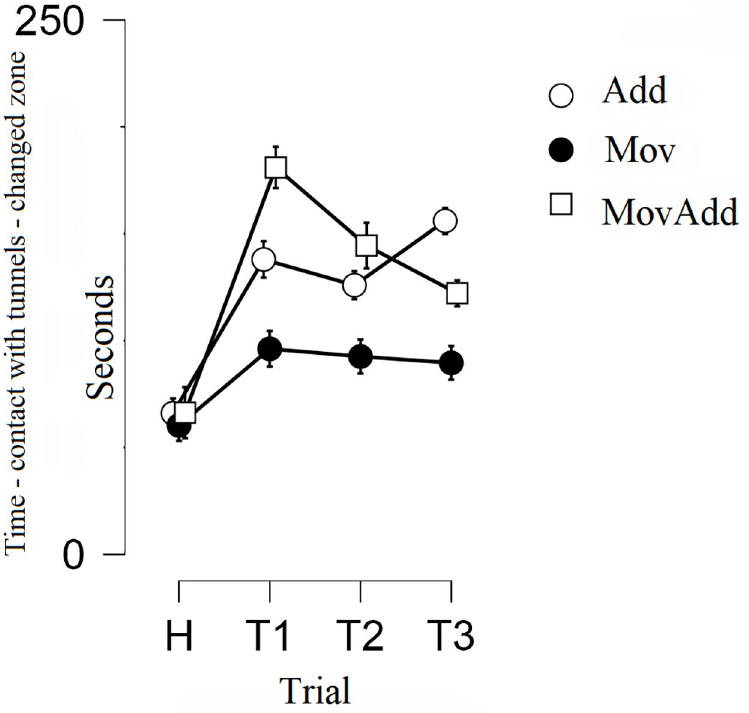
Fig 4. Mean time spent on the contact with tunnels in the changed zone of the chamber. Group Add: addition of novel stationary objects in the experimental box, group Mov: movement of familiar objects in the experimental box, group MovAdd: addition of a novel movable object in the experimental box. Error bars represent standard error (SE).